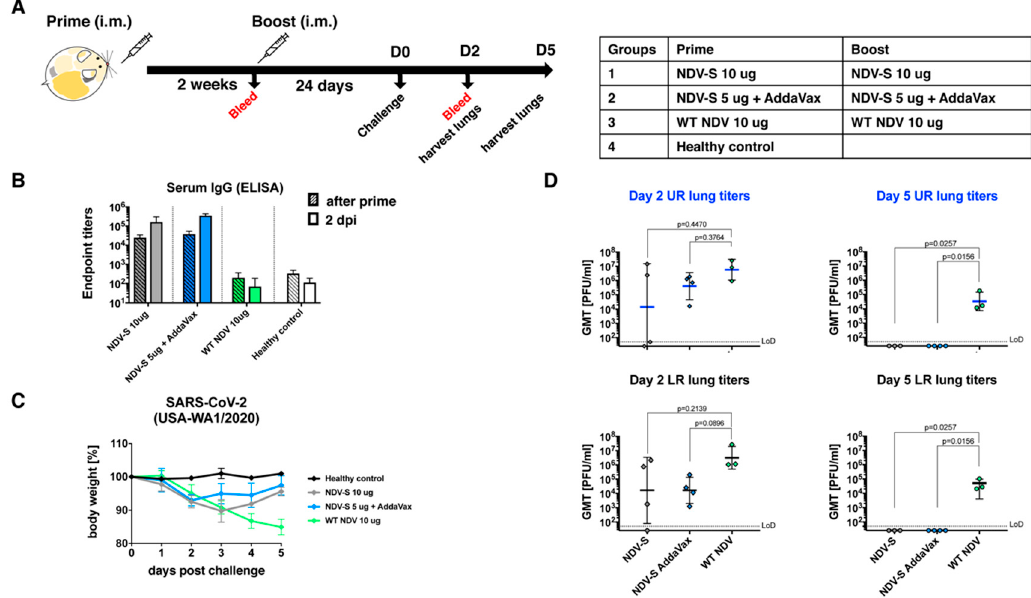
Figure 5. Inactivated NDV-S vaccine attenuates SARS-CoV-2 infection in hamsters. ( A ) Immunization regimen and groups. Golden Syrian hamsters were vaccinated with inactivated NDV-S following a prime-boost regimen with a 2-week interval. Hamsters were challenged 24 days after the boost with the USA-WA1 / 2020 SARS-CoV-2 strain. Four groups of hamsters ( n = 8) were included in this study. Group 1 received 10 µ g of inactivated NDV-S vaccine without any adjuvant. Group 2 received 5 µ g of inactivated NDV-S vaccine adjuvanted with AddaVax. Group 3 receiving the 10 µ g of inactivated WT NDV was included as the vector-only (negative) control. Group 4 animals receiving no vaccine were mock challenged with PBS as healthy controls. ( B ) Spike-specific serum IgG titers. Hamsters were bled pre-boost and a subset of hamsters were terminally bled at 2 days post-infection (dpi). Vaccine-induced serum IgG titers towards the trimeric spike protein were determined by ELISA. Endpoint titers are shown as the readout for ELISA. ( C ) Weight loss of hamsters challenged with SARS-CoV-2. Weight loss of SARS-CoV-2-infected hamsters was monitored for 5 days. ( D ) Viral titers in the lungs. Viral titers in the upper right (UR) and lower right (LR) lung lobes of the animals at 2 and 5 dpi were measured by a plaque assay (LoD: limit of detection). Statistical analysis was performed using the Kruskal–Wallis test with Dunn’s correction for multiple comparisons. P-values between groups were shown.